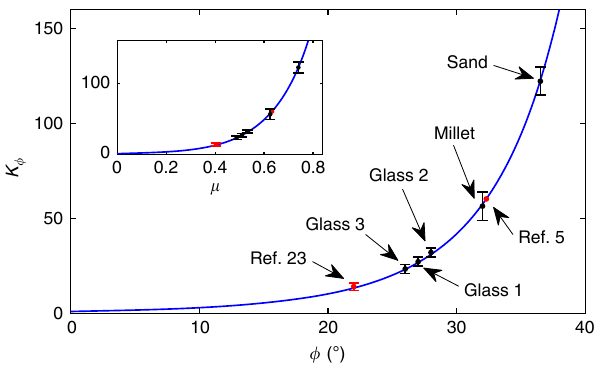
Fig. 5 Validation of the calculation of K ϕ . K ϕ , calculated from Eq. (5) (solid line), and its measured values. The black marks, from all our experiments, and the red mark, from refs. 5,23 , fall squarely on the predicted curve. Error bars represent one standard deviation about the mean. All our experimental values (black points) incur a horizontal error bar of ±2°, which was omitted to avoid clutter. Inset: the relationship between K ϕ and μ = tan ϕ is clearly superlinear, challenging the assumption of linearity in the LFFM. The error bars represent one standard deviation about the mean. Using the data reported in ref. 5 , we estimate the internal friction angle of their poppy seed granules as 32.3° ± 0.3°. The quality of the fi t between the experimental points and the theoretical curve is R 2 =